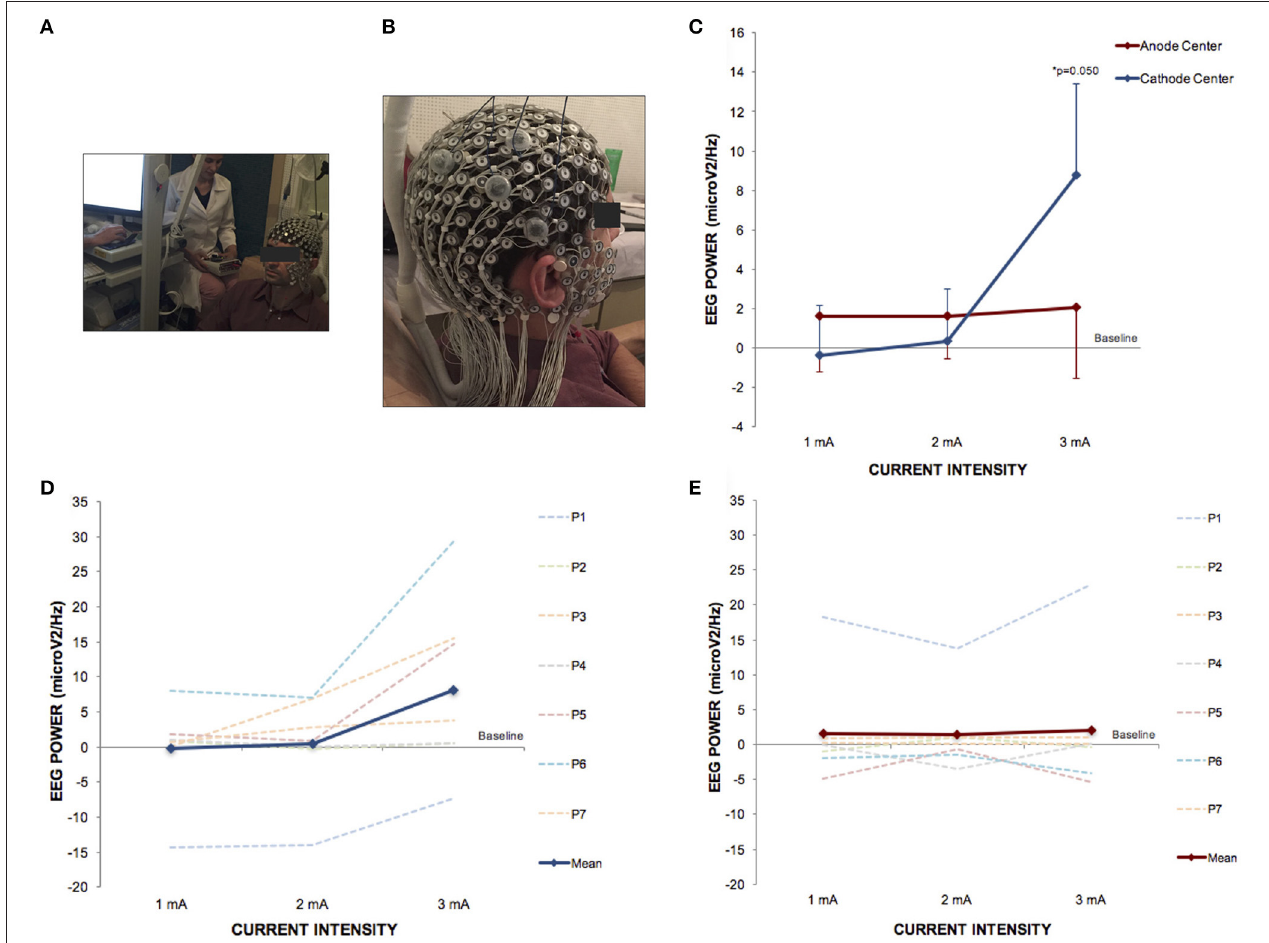
FIGURE 6 | HD-tDCS 3 × 1 over the right temporo-parietal junction can produce effects in power spectral density electroencephalography (EEG) of gamma frequency band. (A) Experimental set up of the EEG trial. (B) Position of the HD-tDCS 3 × 1 electrodes in a male participant. (C) Difference between the EEG power assessed at baseline and at current intensities of 1, 2 and 3mA (mean; s.e.m.). There was an increase of gamma power EEG after cathode center condition at current intensity of 3mA. (D) Difference between the EEG gamma power assessed at baseline and at current intensities of 1, 2, and 3mA after cathode center HD-tDCS 3 × 1 condition of each participant showing the variability of the data and overall effects at current intensity of 3mA. (E) Difference between the EEG gamma power assessed at baseline and at current intensities of 1, 2, and 3mA after anode center HD-tDCS 3 × 1 condition of each participant showing the variability of the data and overall no effects. Written informed consent was obtained from the participants for the publication of this